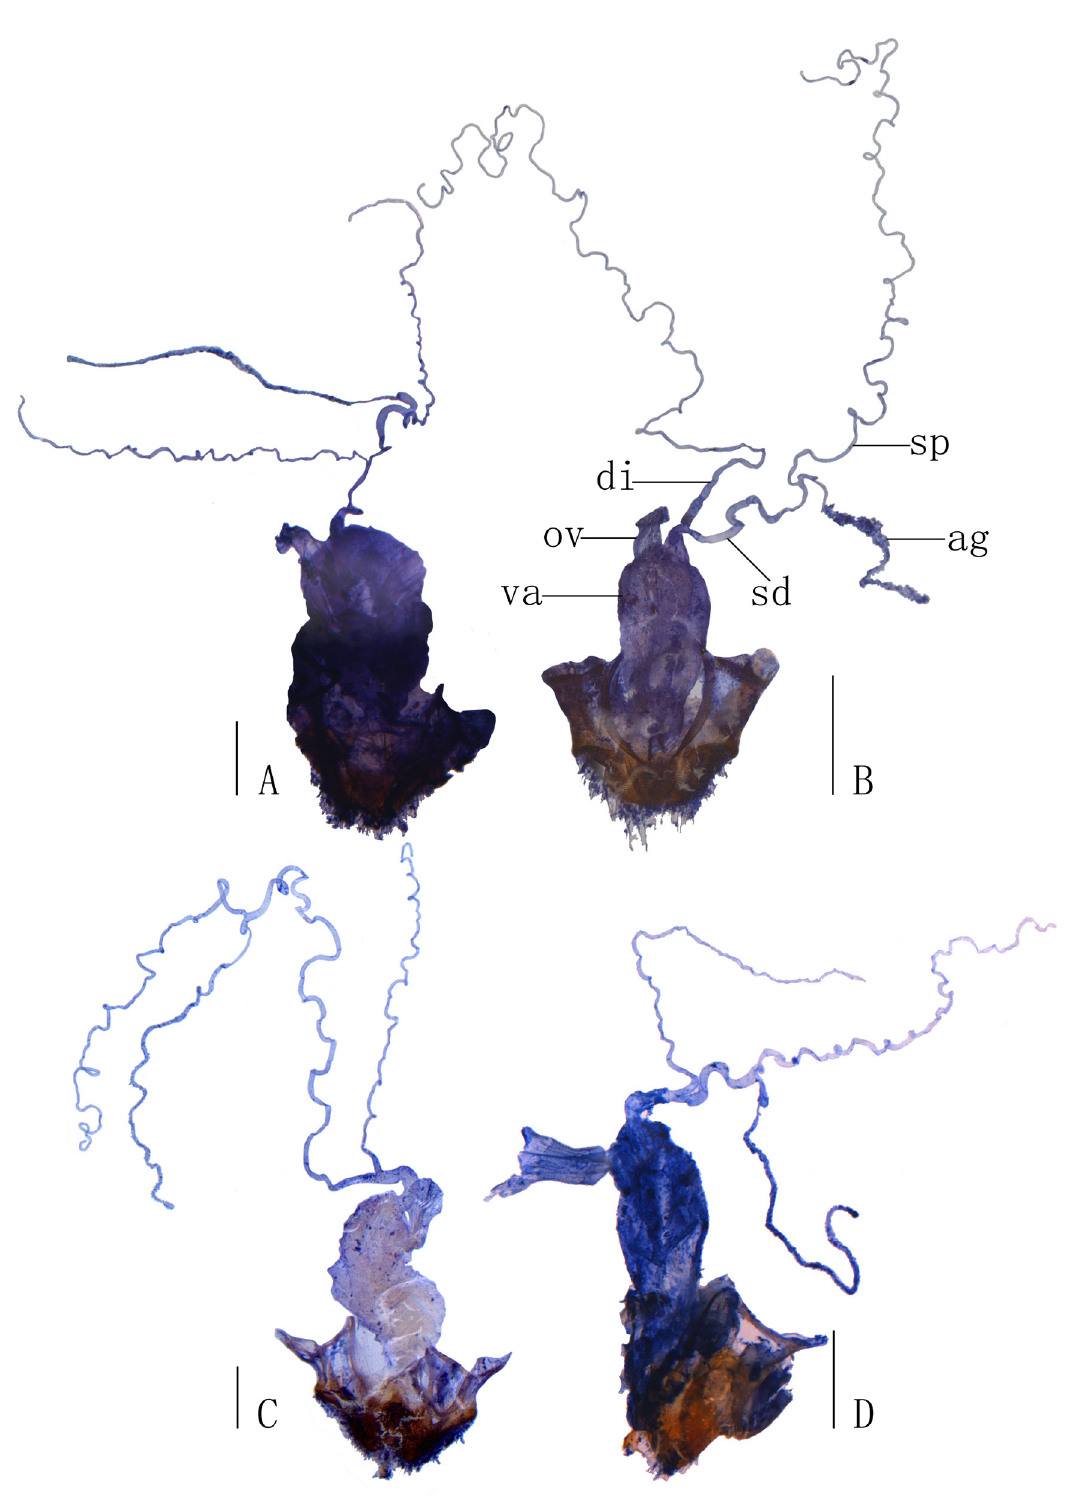
Fig. 4. Female reproductive system, ventral view. A . Stenothemus shaanxiensis Švihla, 2004 stat. nov. (IZAS, Shaanxi). B . S . davidi (Pic, 1926) comb. nov. (IZAS, Shaanxi). C . S . diffusus Wittmer, 1974 (MHBU, Sichuan). D . S . dundai Švihla, 2004 (MHBU, Sichuan). Abbreviations: see Material and methods. Scale bars = 0.5